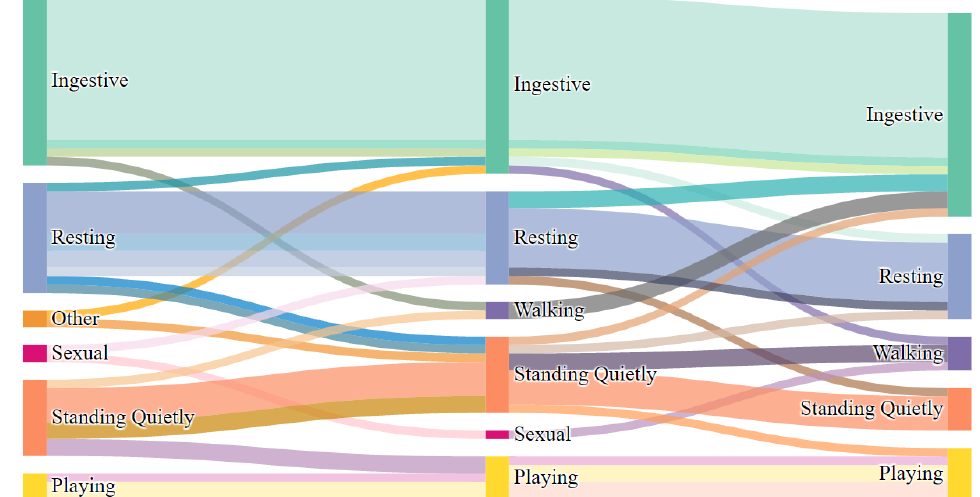
Figure 8. Behavioral flow of all occurrences of E/M. Nodes represent behavioral categories Before E/M, During E/M, and After E/M (left to right). Width of node is relative to number of observations. Here, all pathways can be traced between nodes to show change in behavioral category before, during, and after E/M bout. Interactive Sankey charts are available online (see Data Availability